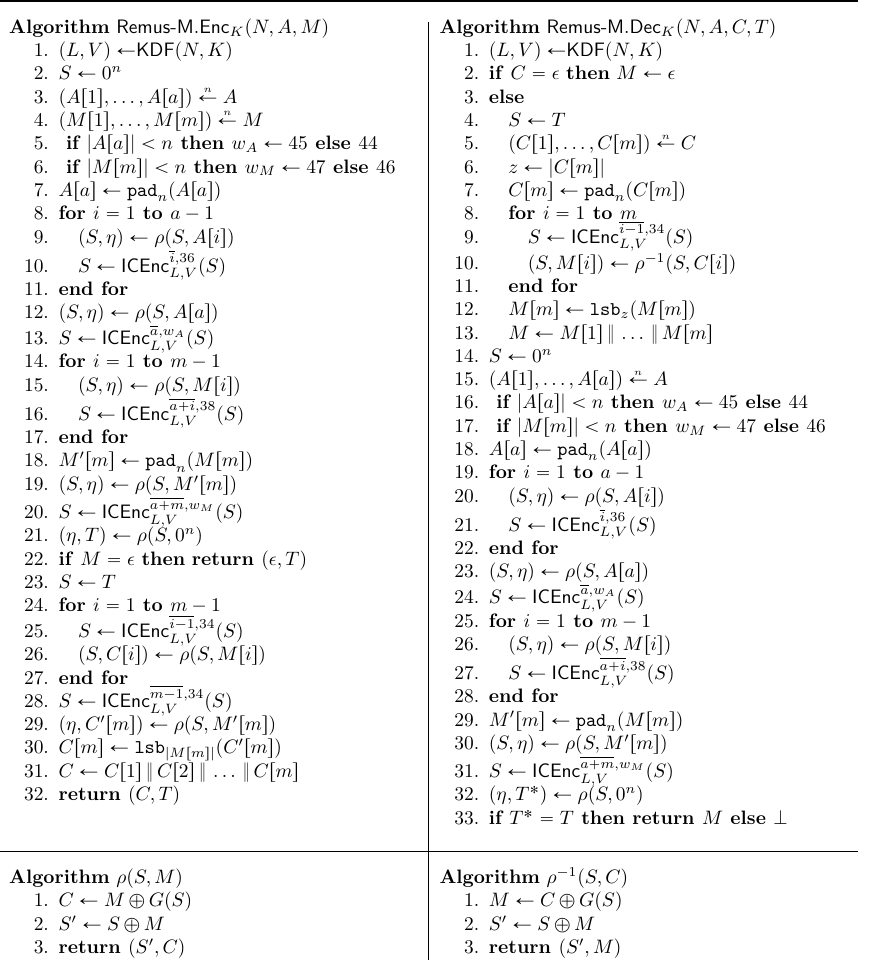
Figure 10: Encryption and decryption of Remus-M . Remus - M 1 is used as a working example.Depending on the Remus-M version, an appropriate variant of ICE will be